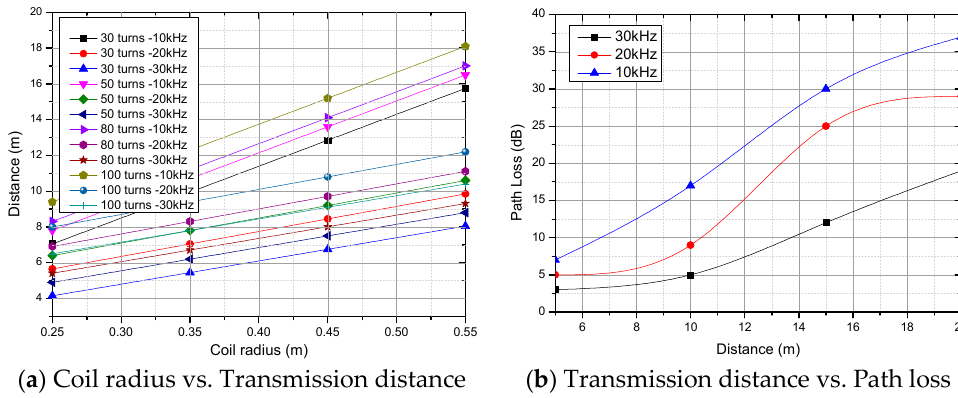
Figure 6. Communication distance veri fi cation.